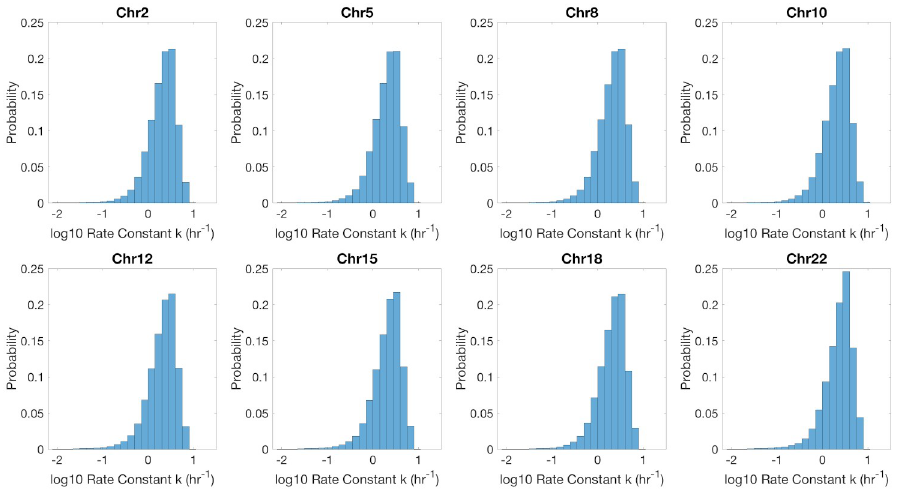
Fig 5. Histogram of remethylation rates, k , for Chromosomes 2, 5, 8, 10, 12, 15, 18, and 22. Histograms are normalized by probability.